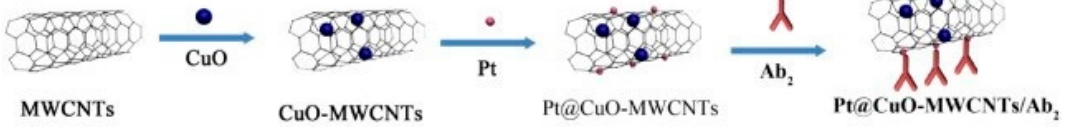
Figure 13. The preparation procedures of Pt@CuO-MWCNTs/Ab2. Reproduced with permission from [38].